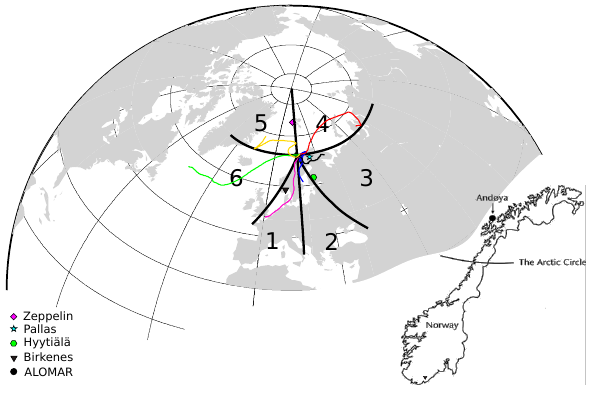
Fig. 1. Location of the ALOMAR station in Northern Norway. The classification sectors of back trajectory air masses are displayed and also the typical trajectories for each air mass origin classification (colored